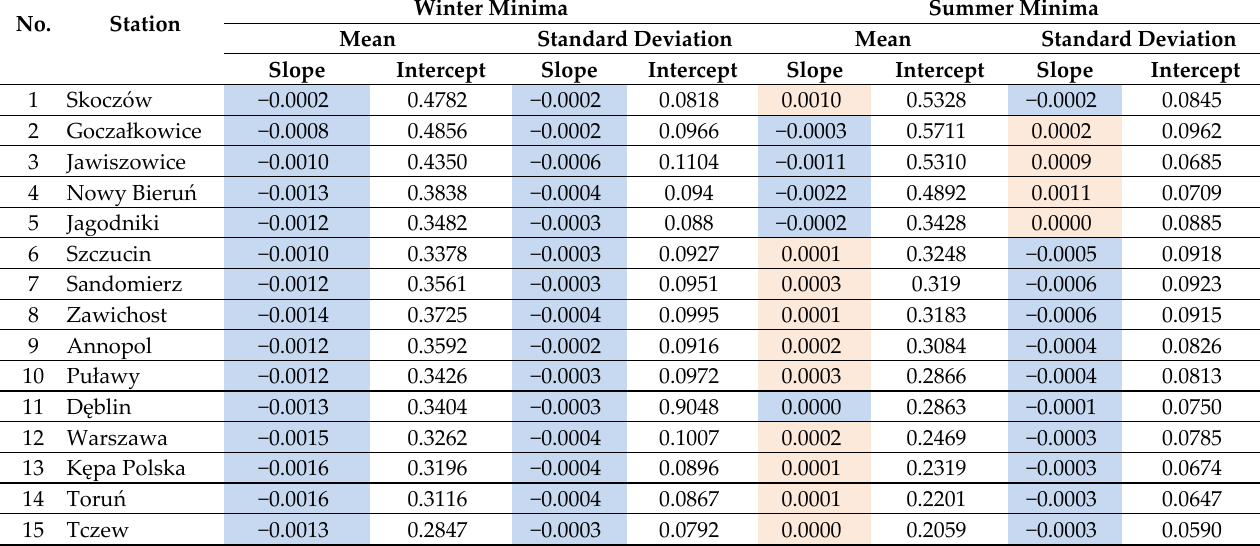
Table 15. Parameters of linear trends in the mean value and standard deviation of the seasonal Gini indices at the stations on the River Vistula; orange colour denotes positive trend, blue colour negative.